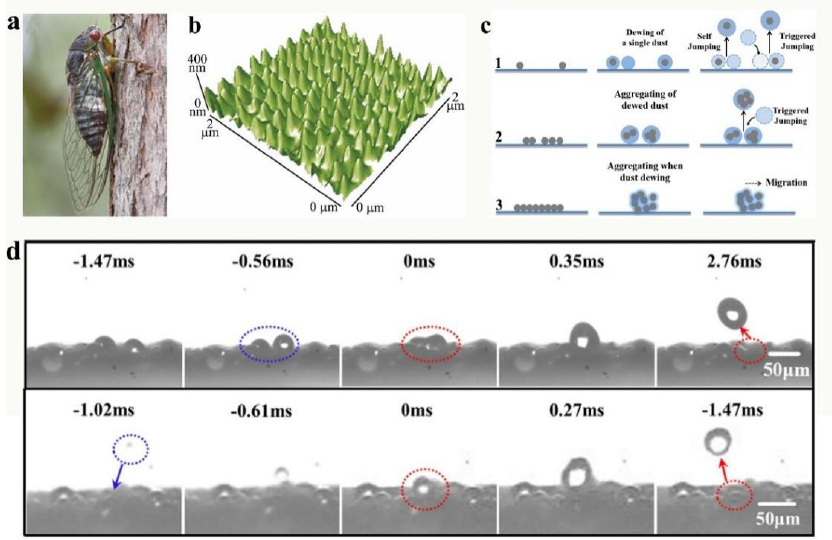
Figure 13. ( a ) The cicadas usually face the sky at rest; ( b ) the micro-/nanostructure of cicada wings, characterized by atomic force microscopy, reproduced with permission from Ref. [162]. ( c ) Three different mechanisms for removing dust particles during the condensation; ( d ) droplets on the coating surface exhibit both active and triggered jump motions, reproduced with permission from Ref. [163].